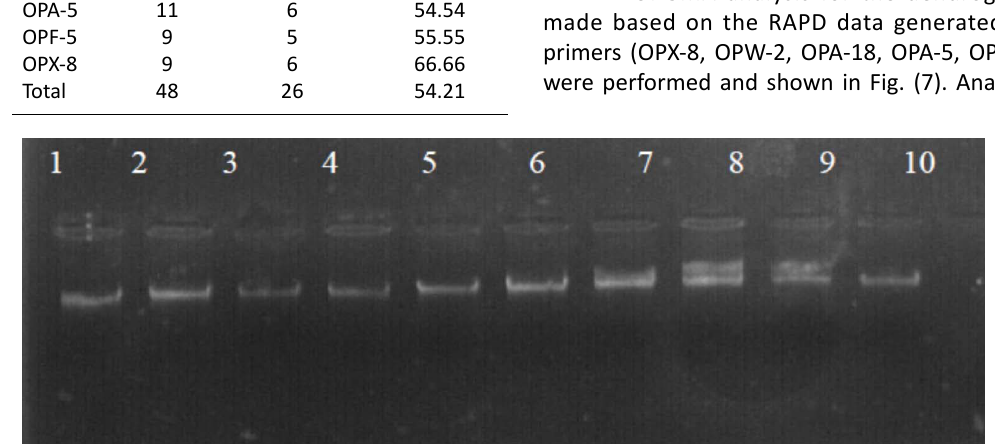
Fig. 1. The electrophoresis pattern of genomic DNA extracted from fenugreek ( Trigonella foenum-graecum ) leaf samples: 1, control; 2, Th-1; 3, Th-2; 4, AVG; 5, MeJA; 6, Th-1 + AVG; 7 Th-1 + MeJA; 8, Th-2 + AVG; 9, Th-2 + MeJA; 10, MeJA + AVG.